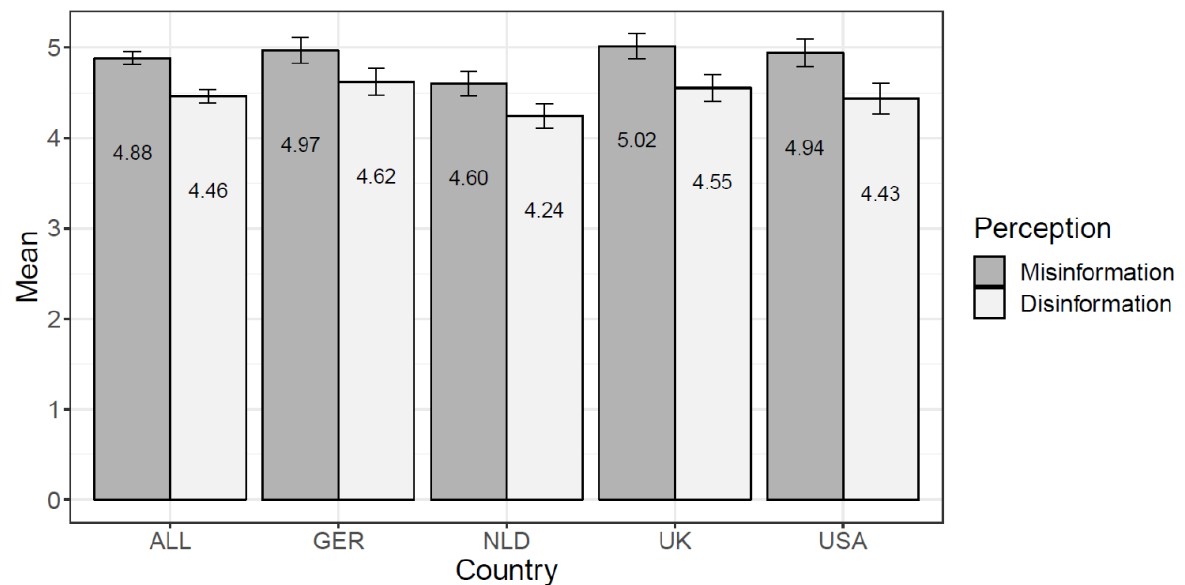
Figure 1. Mean score comparison of mis- and disinformation perceptions related to COVID-19 and SARS-CoV-2 across countries . Individual items were measured on 7-point disagree-agree